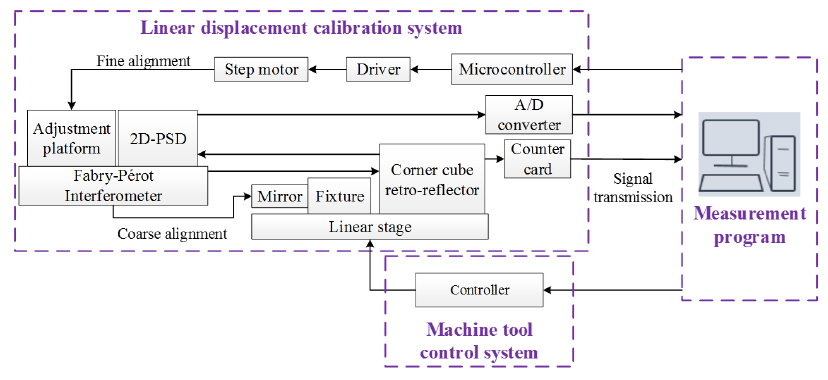
Figure 8. System structure. Figure 8. System